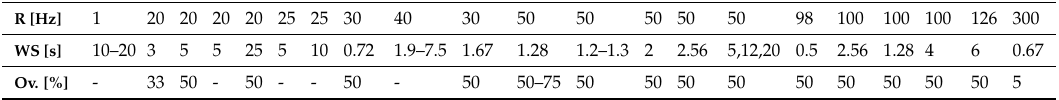
Table 10. Segmentation parameters: sliding-window sizes (WS) [s] and Overlapping (Ov.) [%], along with the recording rate (R) [Hz], used by the publications in Table